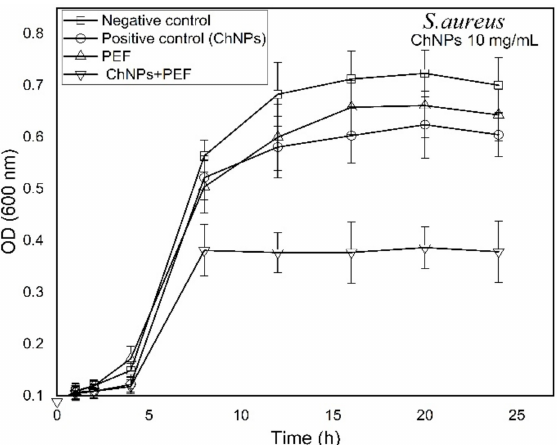
Figure 6. Growth time-dependent characteristic curves of S. aureus as treated by ChNPs (10 mg/mL) and PEF each alone and combined with exposure to